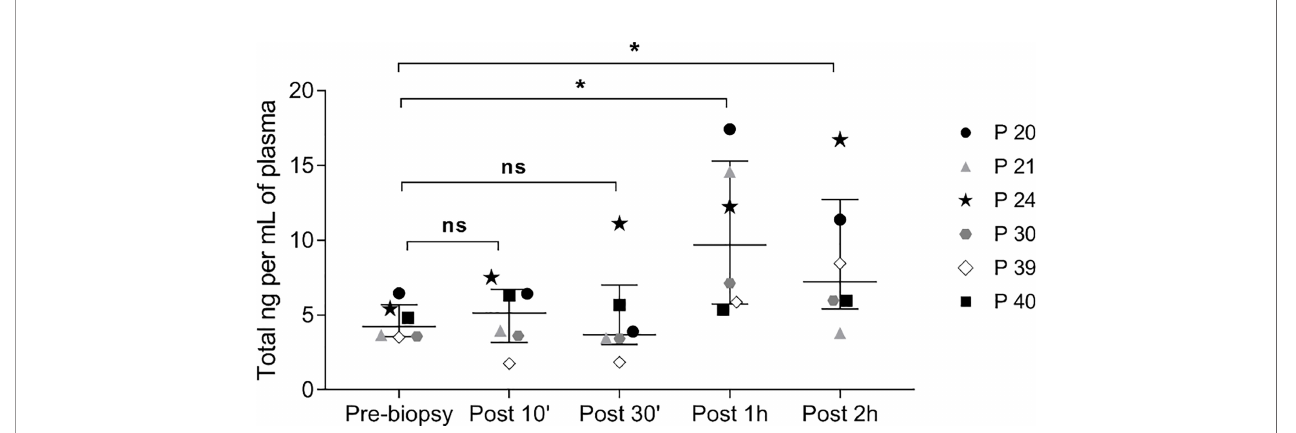
FIGURE 3 | Kinetics of ccfDNA release in circulation after prostate biopsy. Scatter plots, with median and interquartile range, of ccfDNA concentration (ng/mL plasma) as quanti fi ed by the Qubit fl uorometer in the plasma of 6 patients at different time points. ns, not signi fi cant; * P< 0.05; Wilcoxon test for